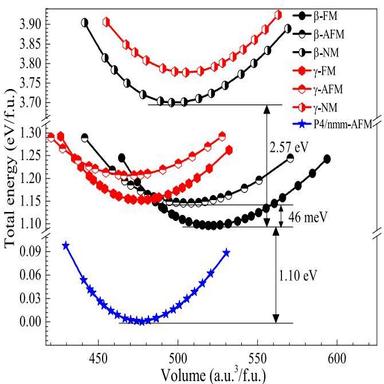
The total energy vs. volume curves for MnPK in different half-Heusler phases and magnetic states are compared with the ground state tetragonal phase (space group P4/nmm) in the antiferromagnetic state. The ground state minimum is taken as the zero of energy.